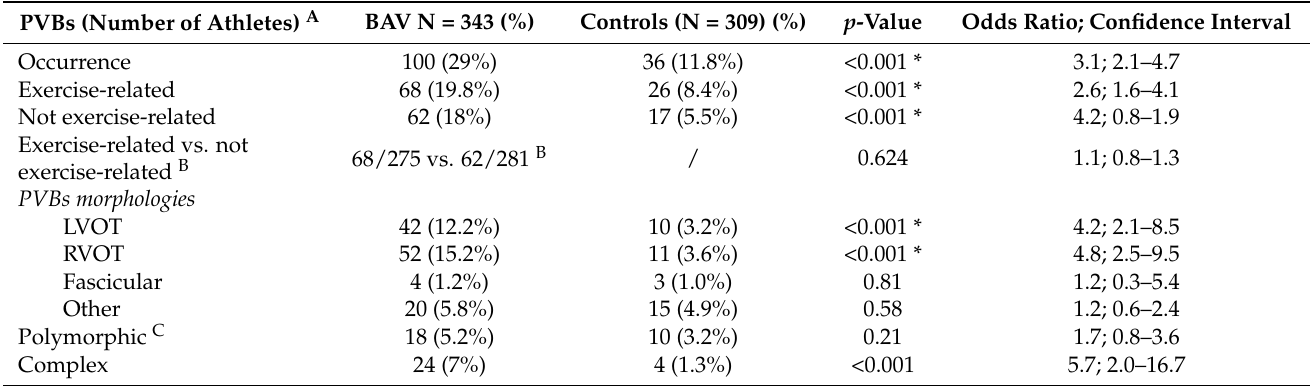
Table 2. PVBs’ rate of occurrence, relationship with exertion, morphology, number of morphologies and complexity in BAV group vs.